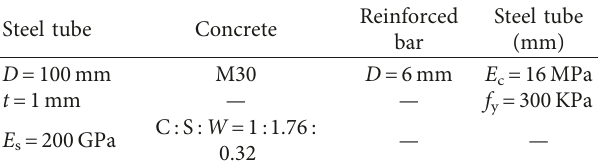
Table 6: Material properties of the concrete core and steel tube. Steel tube